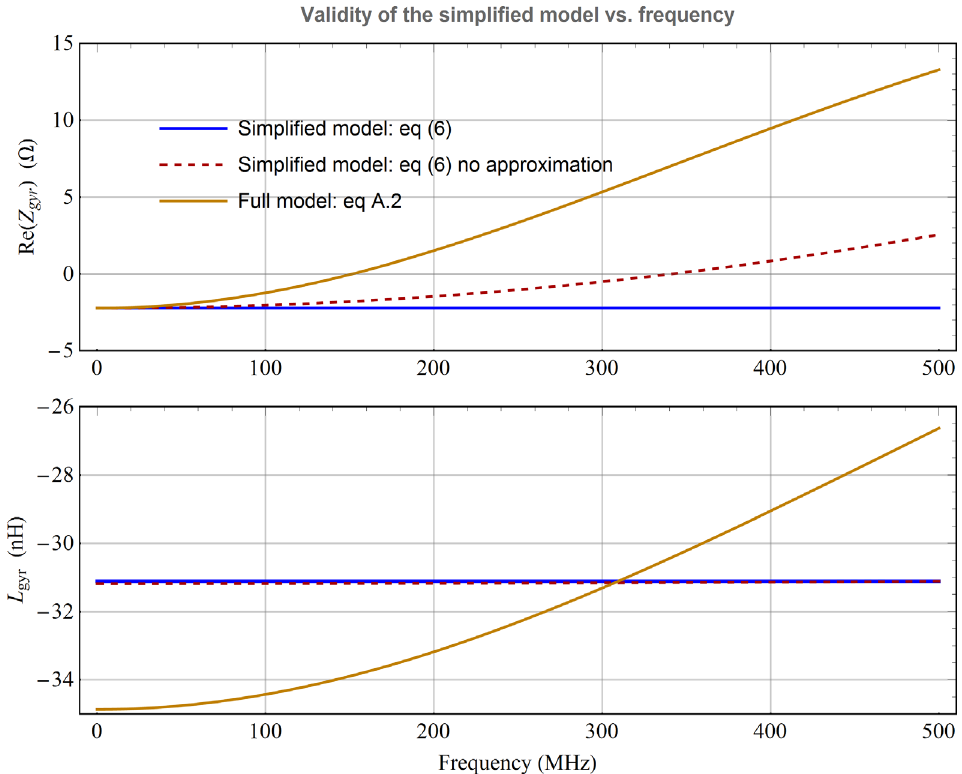
Fig. A.2. Comparison of the simpli fi ed and full model of the gyrator circuit from 100 to 500MHz. Circuit parameters are g m =15 mS, and C =7 pF. (Top) Real part of the input impedance. (Bottom) Equivalent inductance of the input impedance.